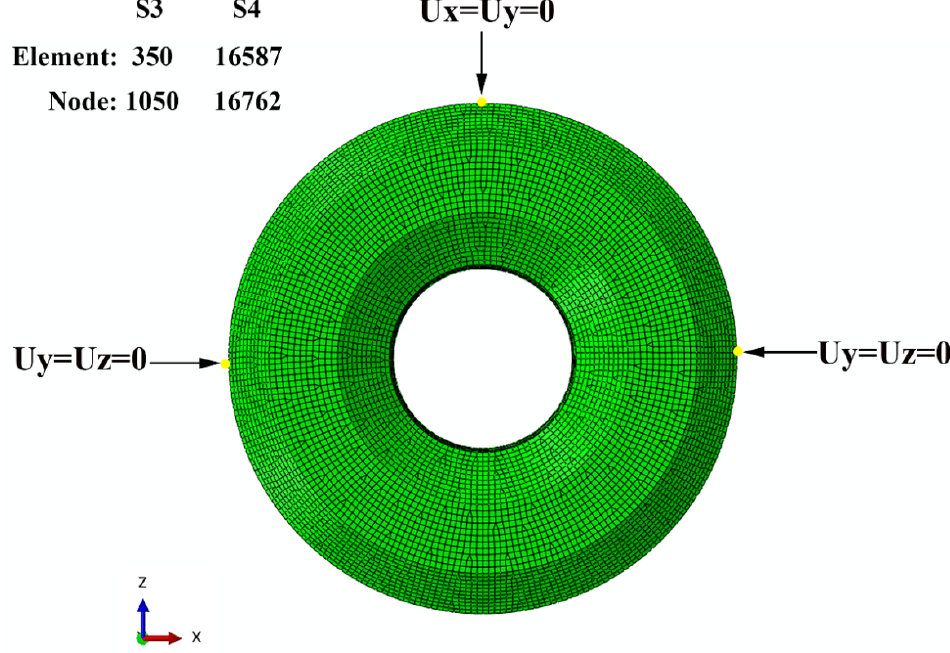
Figure 3. Finite-element and boundary conditions of toroidal pressure hull with discrete octagonal cross-section.